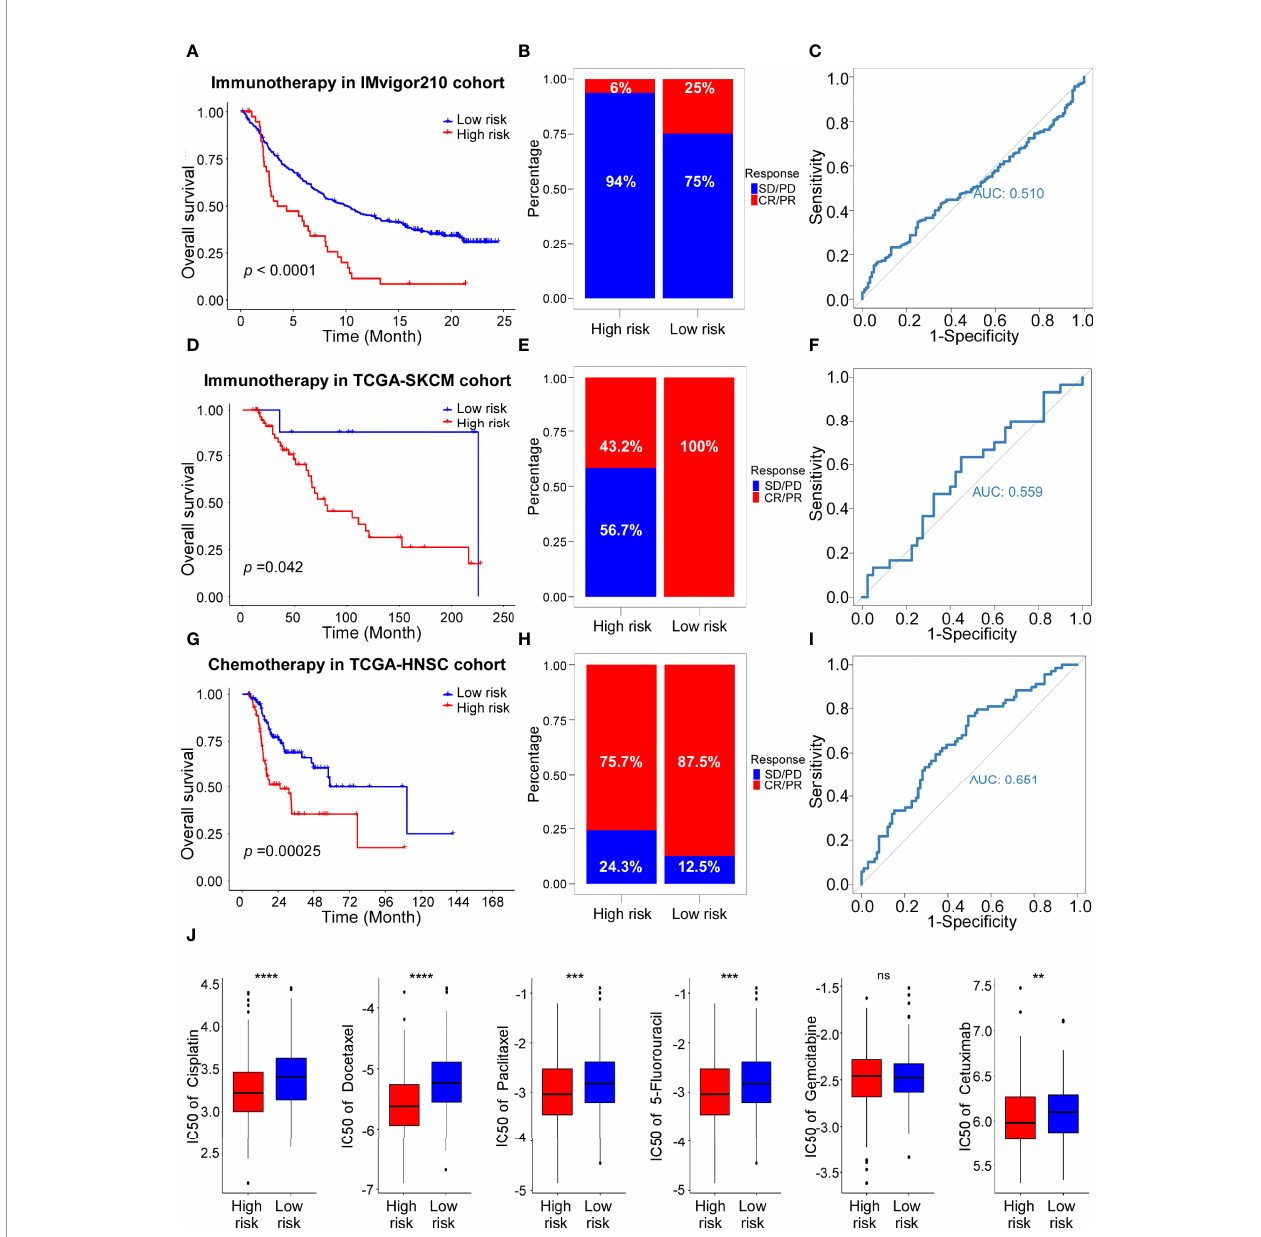
FIGURE 7 | The role of risk scores in the prediction of therapeutic outcomes. (A) Kaplan – Meier curves for the OS of high-risk and low-risk groups in the IMvigor210 cohort. Log-rank test, P <0.0001. (B) Rate of CR (Complete Response)/PR (Partial Response) and PD (Progressive Disease)/SD (Stable Disease) in high and low risk groups in the IMvigor210 cohort. (C) ROC curve of risk score in IMvigor210 cohort on OS. (D) Kaplan – Meier curves for the OS of high-risk and low-risk groups in the TCGA-SKCM cohort with Immunotherapy. Log-rank test, P =0.042. (E) Rate of CR/PR and PD/SD in high and low risk groups in the TCGA-SKCM cohort with Immunotherapy. (F) ROC curve of risk score in TCGA-SKCM cohort with Immunotherapy on OS. (G) Kaplan – Meier curves for the OS of high-risk and low-risk groups in the TCGA-HNSC cohort with Chemotherapy. Log-rank test, P =0.00025. (H) Rate of CR/PR and PD/SD in high and low risk groups in the TCGA-HNSC cohort with Chemotherapy. (I) ROC curve of risk score in TCGA-HNSC cohort with Chemotherapy on OS. (J) The estimated IC50s of clinical chemotherapeutic and targeted drugs of HNSCC in high-risk and low-risk groups. From left to right, cisplatin, docetaxel, paclitaxel, 5- fl uorouracil, gemcitabine,